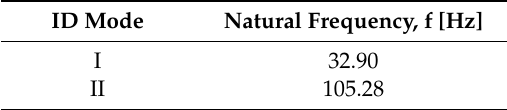
Table 2. Beam natural frequencies (FEA